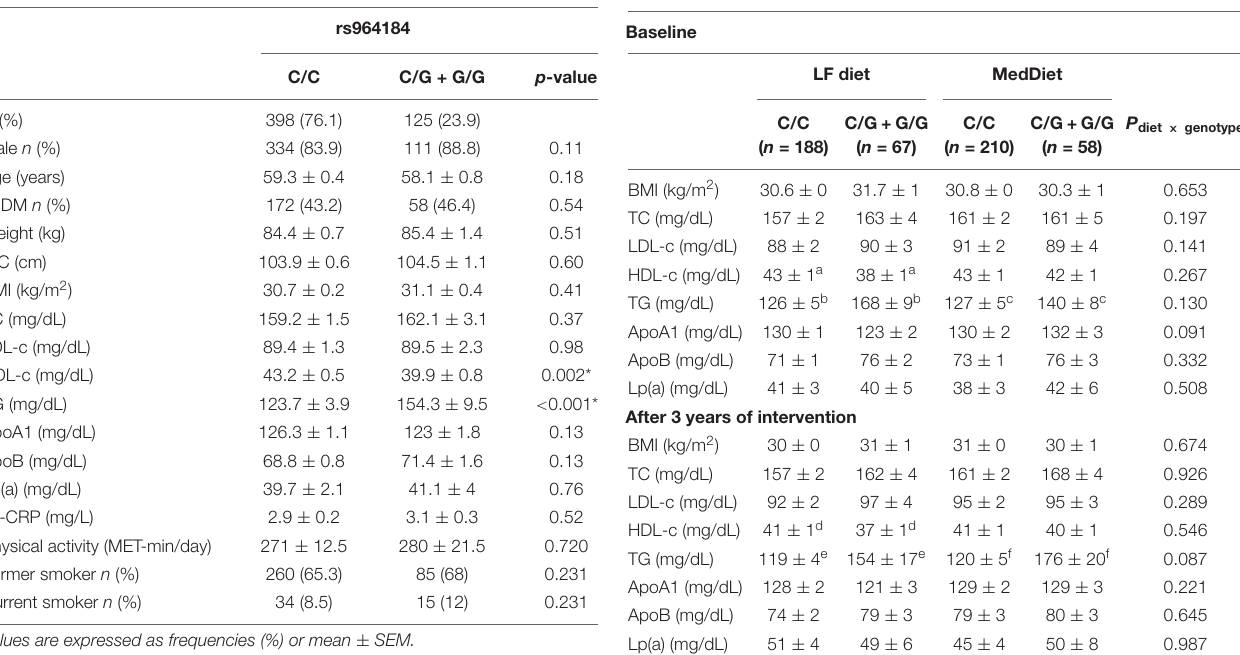
TABLE 2 | Fasting lipid profile, body mass index at baseline, and their changes after 3 years of intervention according to rs964184 SNP and dietary patterns.